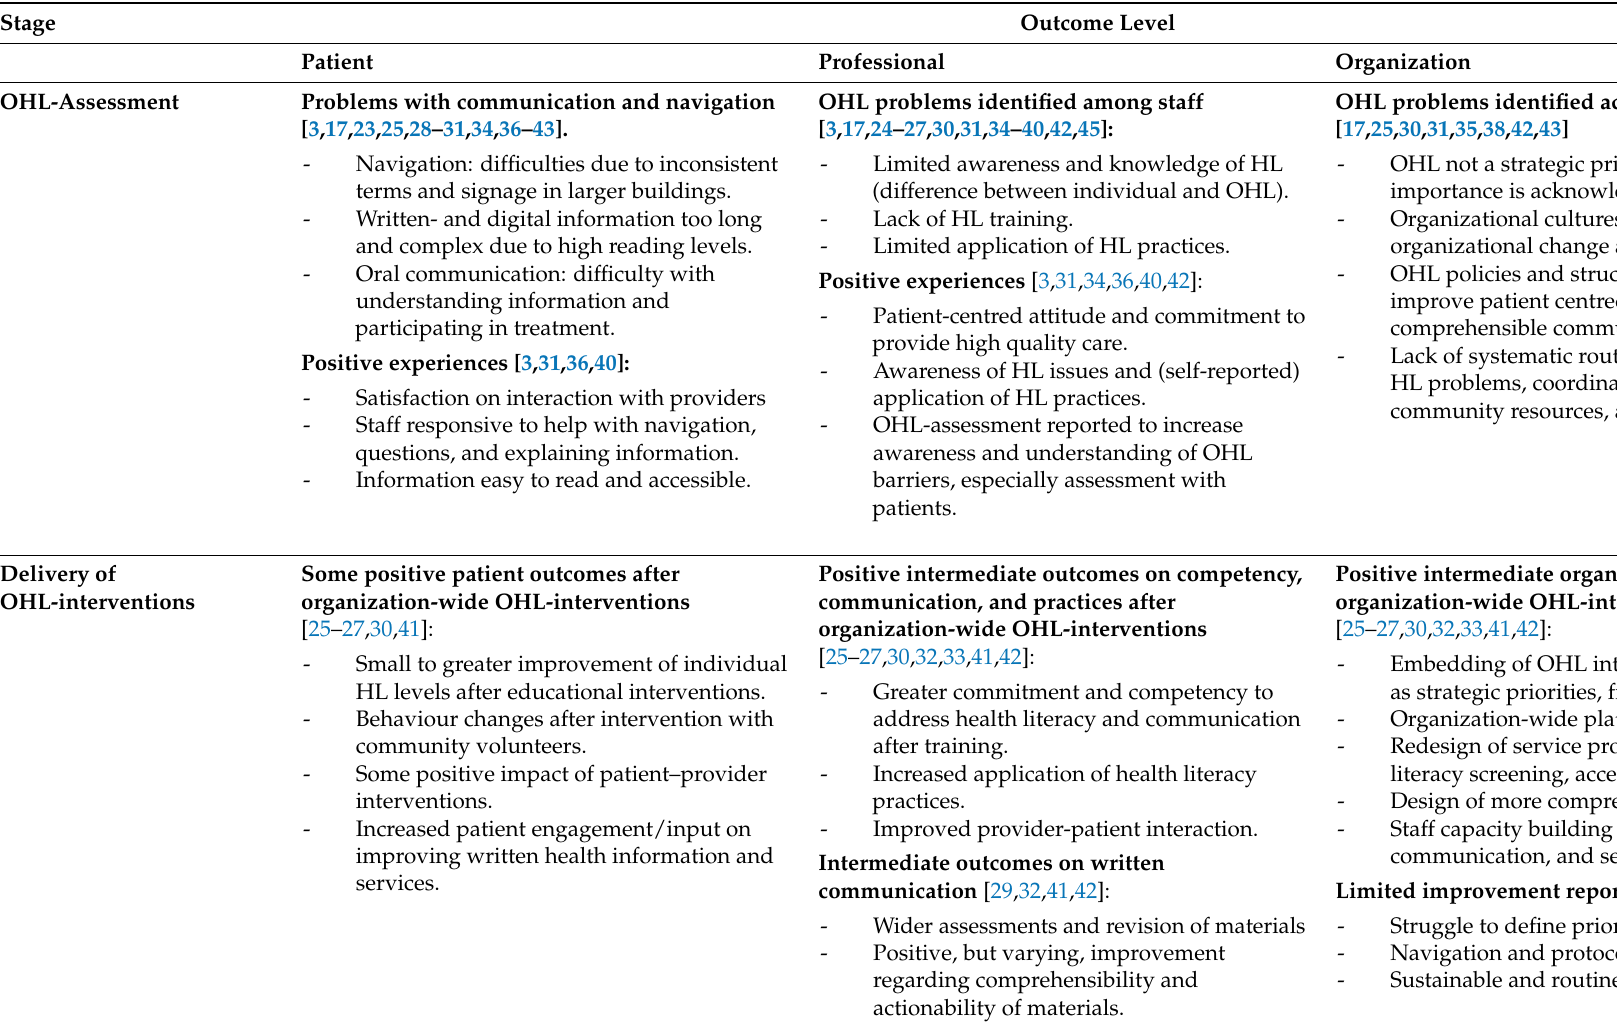
Table 2. Outcomes of OHL Assessments and